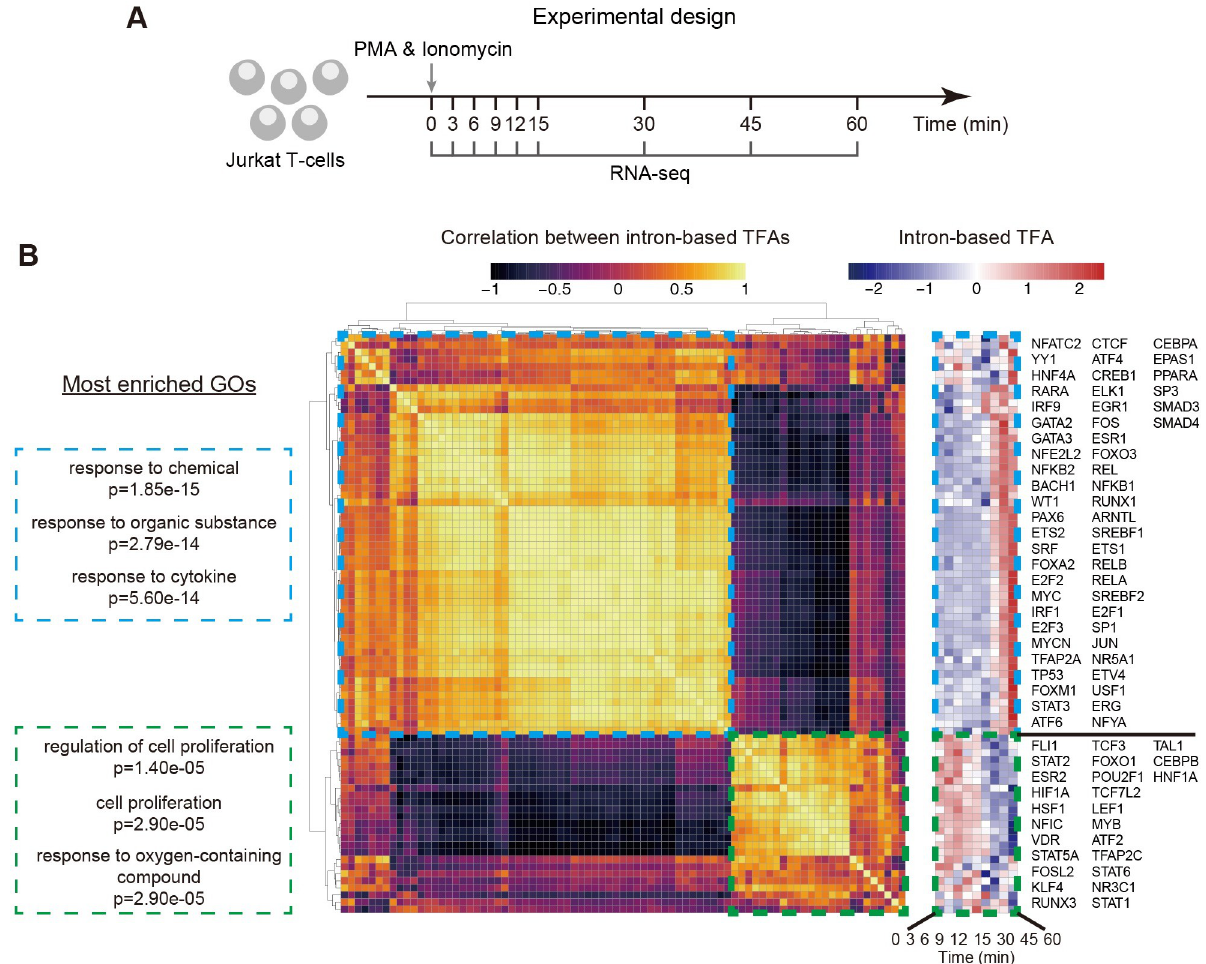
Fig 4. Decoding global transcriptional regulation during the early activation of Jurkat T cells by profiling intron-based TF activities. (A) Schematic of our experimental design. Time-series RNA-seq data were acquired during early Jurkat T cell activation. Each time point has two replicates. (B) Hierarchical clustering uncovered two functionally and dynamically distinct TF modules. Clustering was performed based on the Pearson correlation between intron-based TFAs. Two TF modules are indicated by dashed boxes. Three most enriched GO biological process terms for each module are shown. Intron-based TFA dynamics after z-score normalization of each TF are shown on the right. Note that only TFs with non- zero expression values were included in the analysis (Materials and Methods), and TF symbols are ordered from top to bottom, then left to right. See also S5 Fig for analogous analyses using exon-based and total reads-based